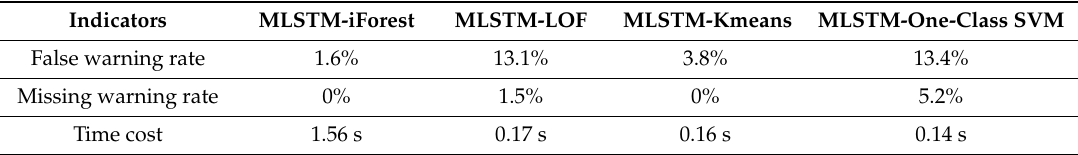
Table 4. Indicator comparison for unsupervised